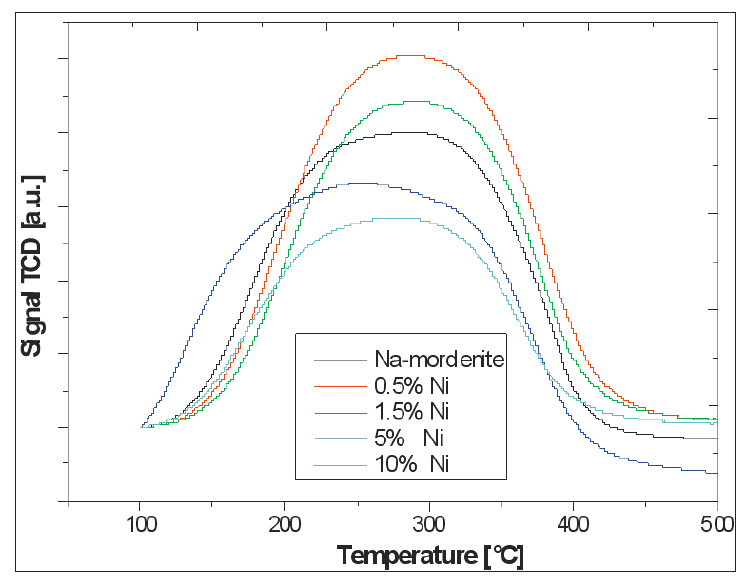
Figure 1. NH -TPD profiles for Na-Mordenite and 3